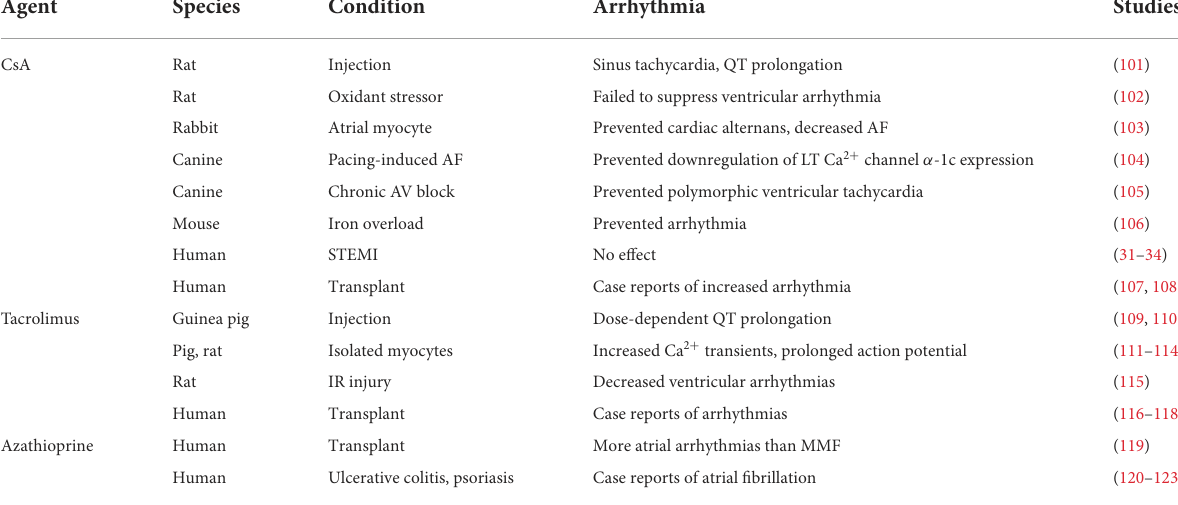
TABLE 3 Studies examining effects of immunosuppression on